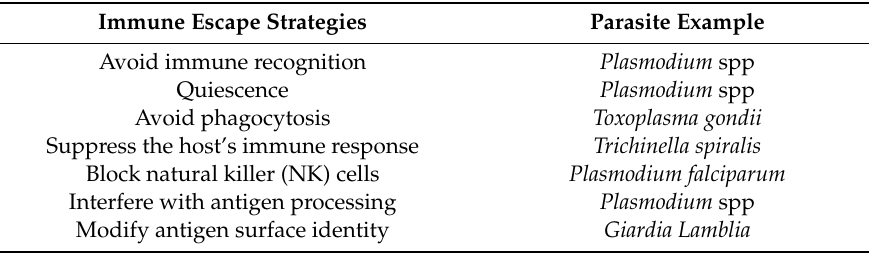
Table 1. A range of immune escape strategies utilized by